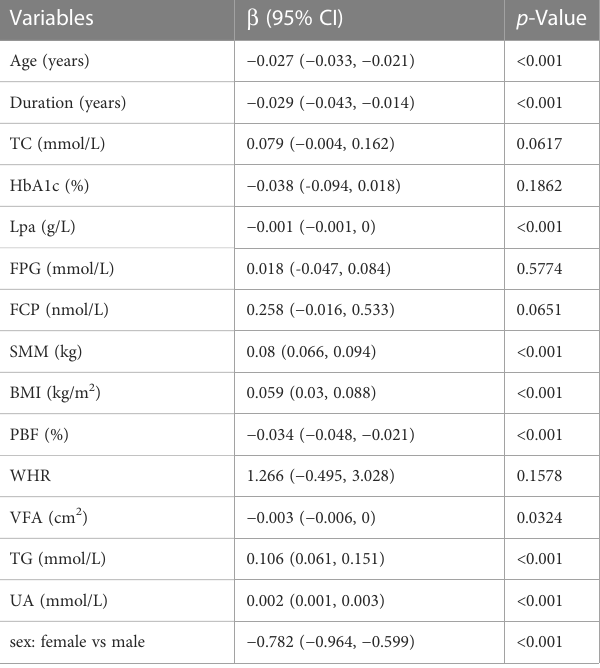
TABLE 2 Association of phase angle and measured indicators.